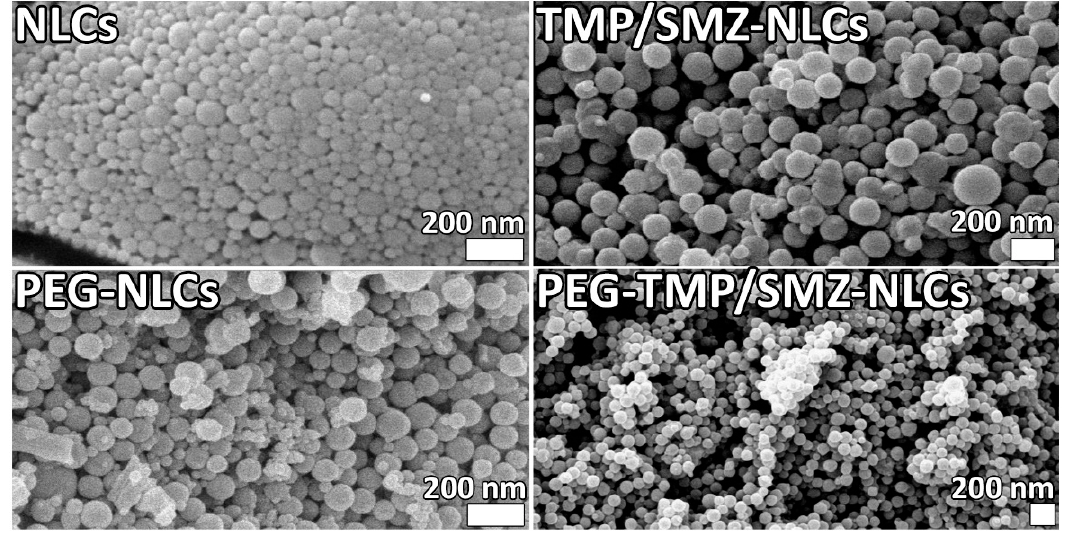
Figure 2. Scanning electron microscopy (SEM) of NLCs, TMP/SMZ-NLCs, PEG-NLCs, and PEG- TMP/SMZ-NLCs.